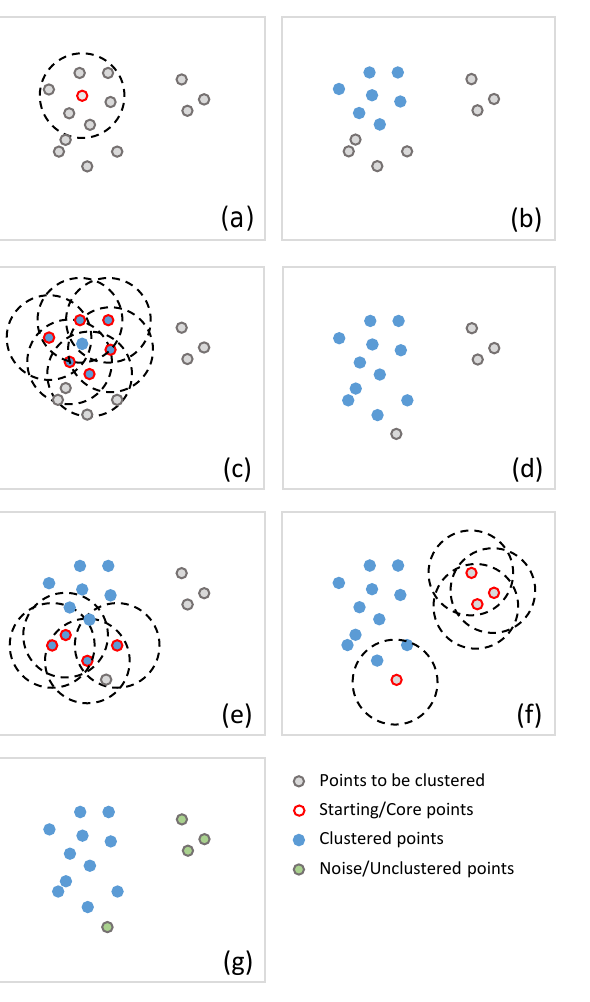
Figure 2. Graphical representation of the DBSCAN approach, with MinPts =4 as an example: ( a ) a starting point is first selected in a set of points to be clustered; if the number of points in a circle with a radius of Eps centered on the starting point is greater or equal to MinPts , all of the points are included in the same cluster: in this example, there are 6 points in the circle, thus the condition is validated; ( b ) a first cluster is created with the staring point and the 6 new members; ( c ) each new member of the cluster becomes a starting point; the condition presented in ( b ) is applied again: in this example, only one starting point respects the conditions, then ( d ) 4 points are included in the cluster; ( e ) the condition is applied again on the new members; in this example, the condition of a minimum of points in the circle is not verified: the process stops and a cluster is then complete; ( f ) a new starting point is selected outside the existing clusters and the process is repeated until all points have been proceeded; ( g ) in this example, 11 points have been grouped together in one cluster and 4 points are not